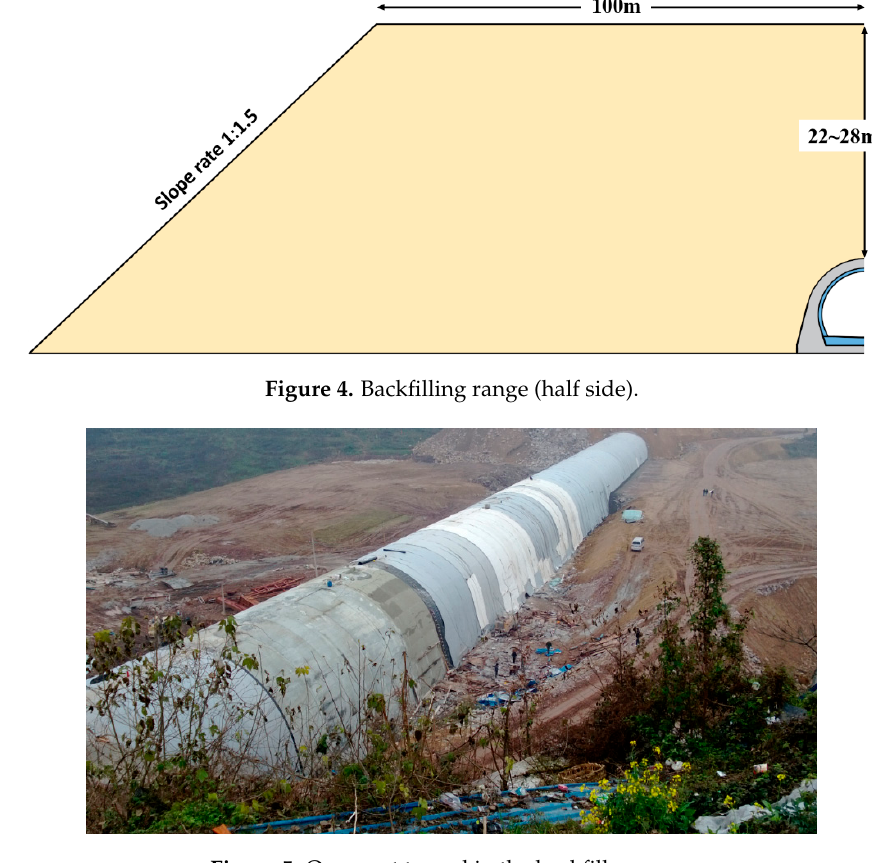
Figure 5. Open-cut tunnel in the backfill process.